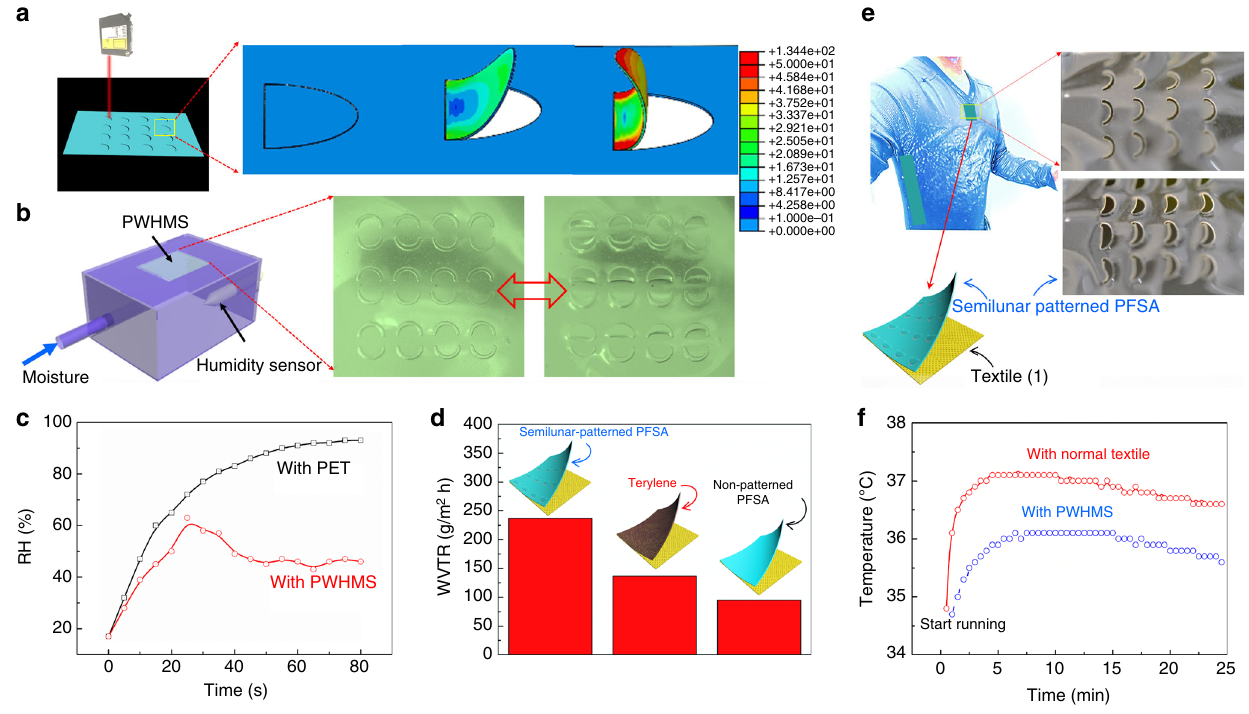
Fig. 5 Personal humidity and heat management system. a Fabrication of the actuator array using a laser cutting and patterning system. b Schematic diagram of the homemade humidity chamber used for quantitative measurement of the humidity control ability of personal humidity and heat management system. The photo of the actuator array before and after self-adaptive actuation. (Scale bar is 1 cm). c Plots of time-dependent humidity change within the chamber af fi xed with normal PET fi lm and personal humidity and heat management system. d Water vapor transmission rate test of three type of PFSA fi lms with semilunar patterns shirt, standard polyester fabric sports shirt, and PFSA fi lm (without any pattern)-based shirt. e , f A PFSA matrix with semilunar patterns able to curl in an outward direction was integrated into commercial sports shirt to develop clothing for personal humidity and heat management. Plots of the time-dependent skin temperature. (Scale bar is 1.5